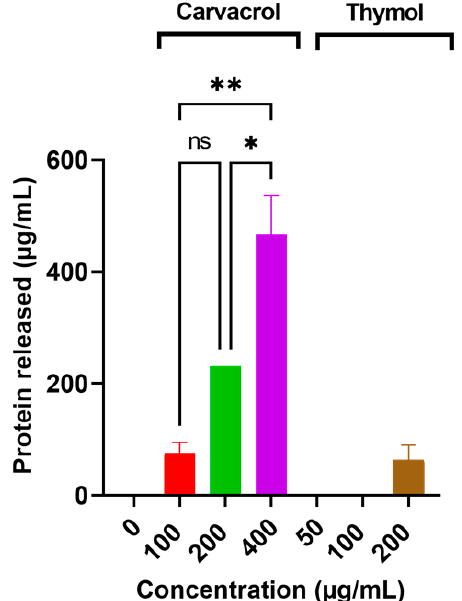
Figure 5. Release of the intracellular protein from desiccation-adapted Salmonella Tennessee E2007000304 when treated with different concentrations of carvacrol or thymol for 2.0 h at 37 °C. Each data point represents mean ± standard deviation. Asterisk (*) denotes significant difference at p < 0.05; and ** at p < 0.01. “ns” denotes non-significant (i.e., p > 0.05)